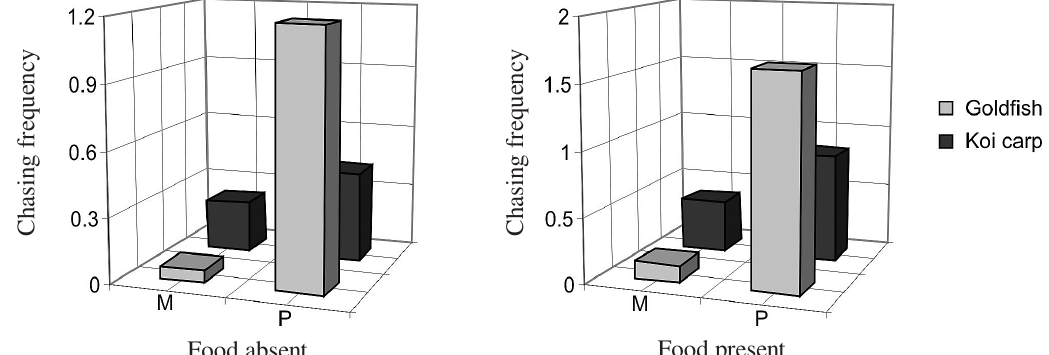
Food Fig. 2. Standardised (per capita) chasing frequency per trial estimated for koi carp and goldfish under monoculture (M) and poly- culture (P) conditions in aquaria in the presence and absence of food (plankton)